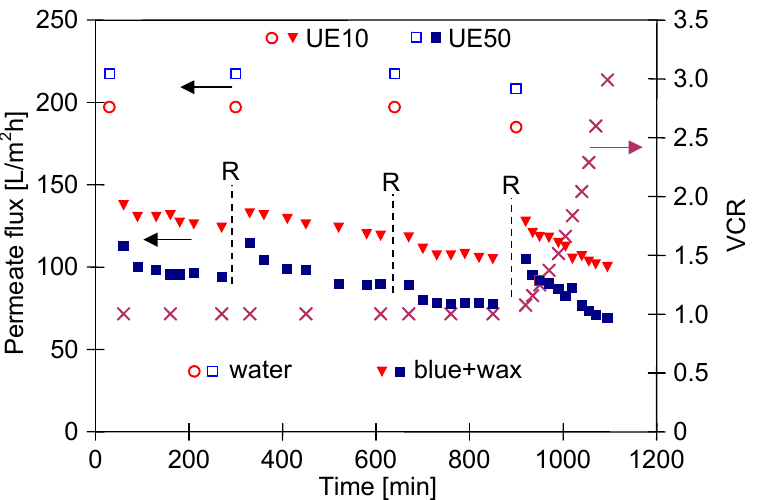
Figure 12. Changes in the permeate flux and VCR during the UF process. Feed: the blue+wax mixture, periodic rinsing (30 min) with green solution (points R). The continuous permeate collection from 900 min.